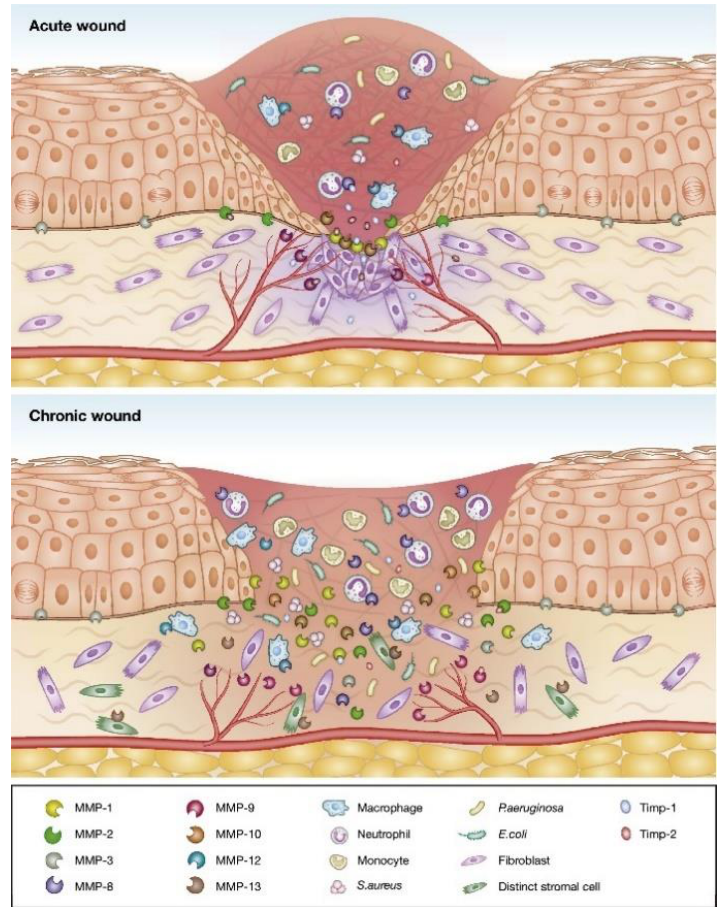
Figure 2. Depiction of acute and chronic wound scenarios with dysregulated matrix metalloproteinases (MMPs) and infiltration of bacteria (used with permission from [126]).